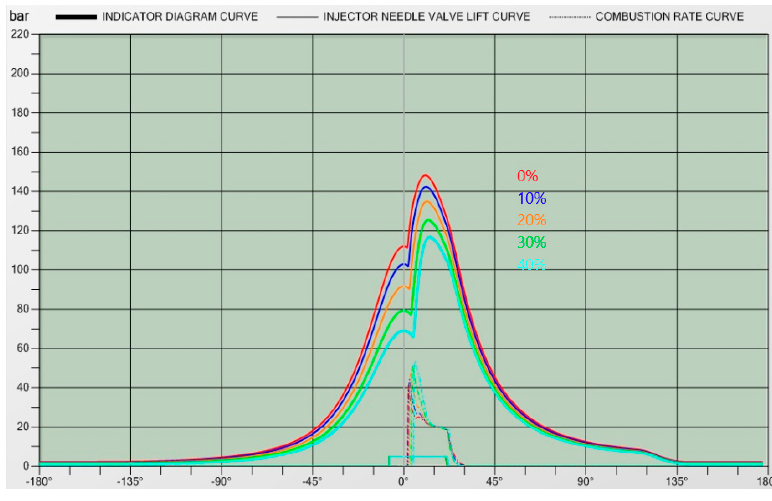
Figure 6. Indicator diagram of the fouled cooler—air side.